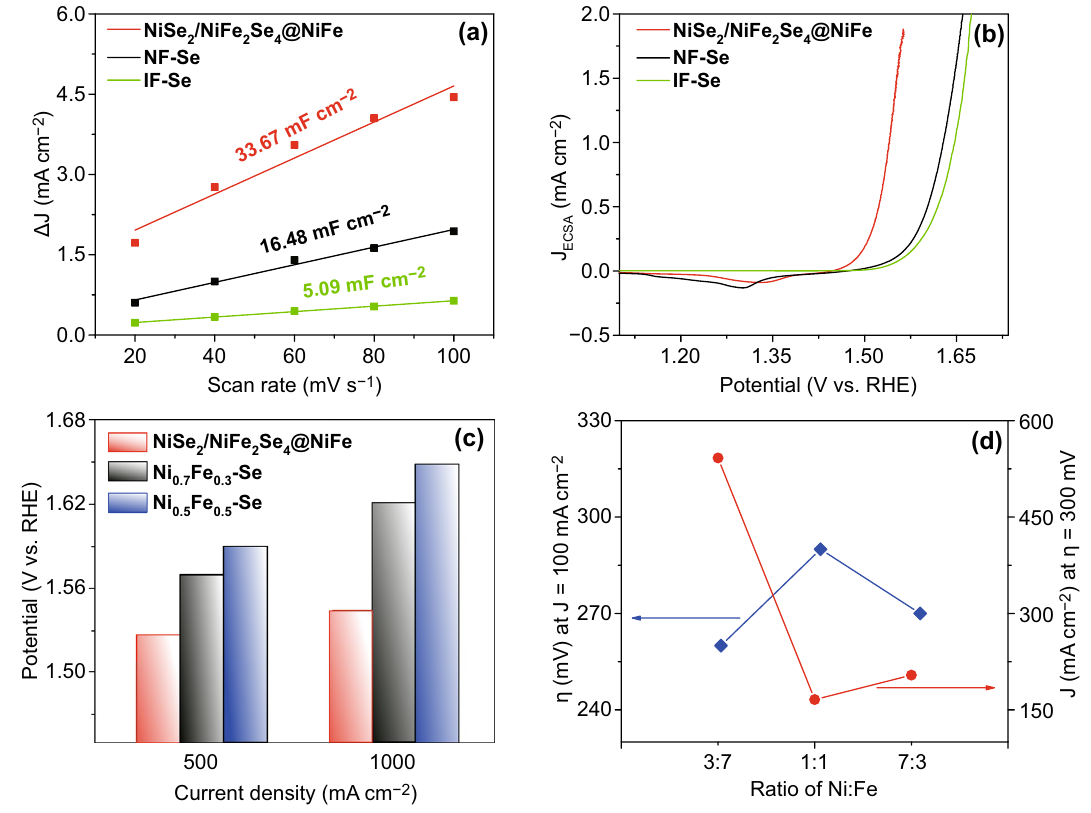
Fig. 3 a ECSAs and b ECSA-normalized polarization curves of NiSe 2 /NiFe 2 Se 4 @NiFe, NF-Se, and IF-Se. c Comparison of potentials required at 500 and 1000 mA cm −2 for NiSe 2 /NiFe 2 Se 4 @NiFe, Ni 0.7 Fe 0.3 –Se, and Ni 0.5 Fe 0.5 –Se. d OER activities of NiSe 2 /NiFe 2 Se 4 @NiFe, Ni 0.7 Fe 0.3 – Se, and Ni 0.5 Fe 0.5 –Se at 100 mA cm −2 and 300